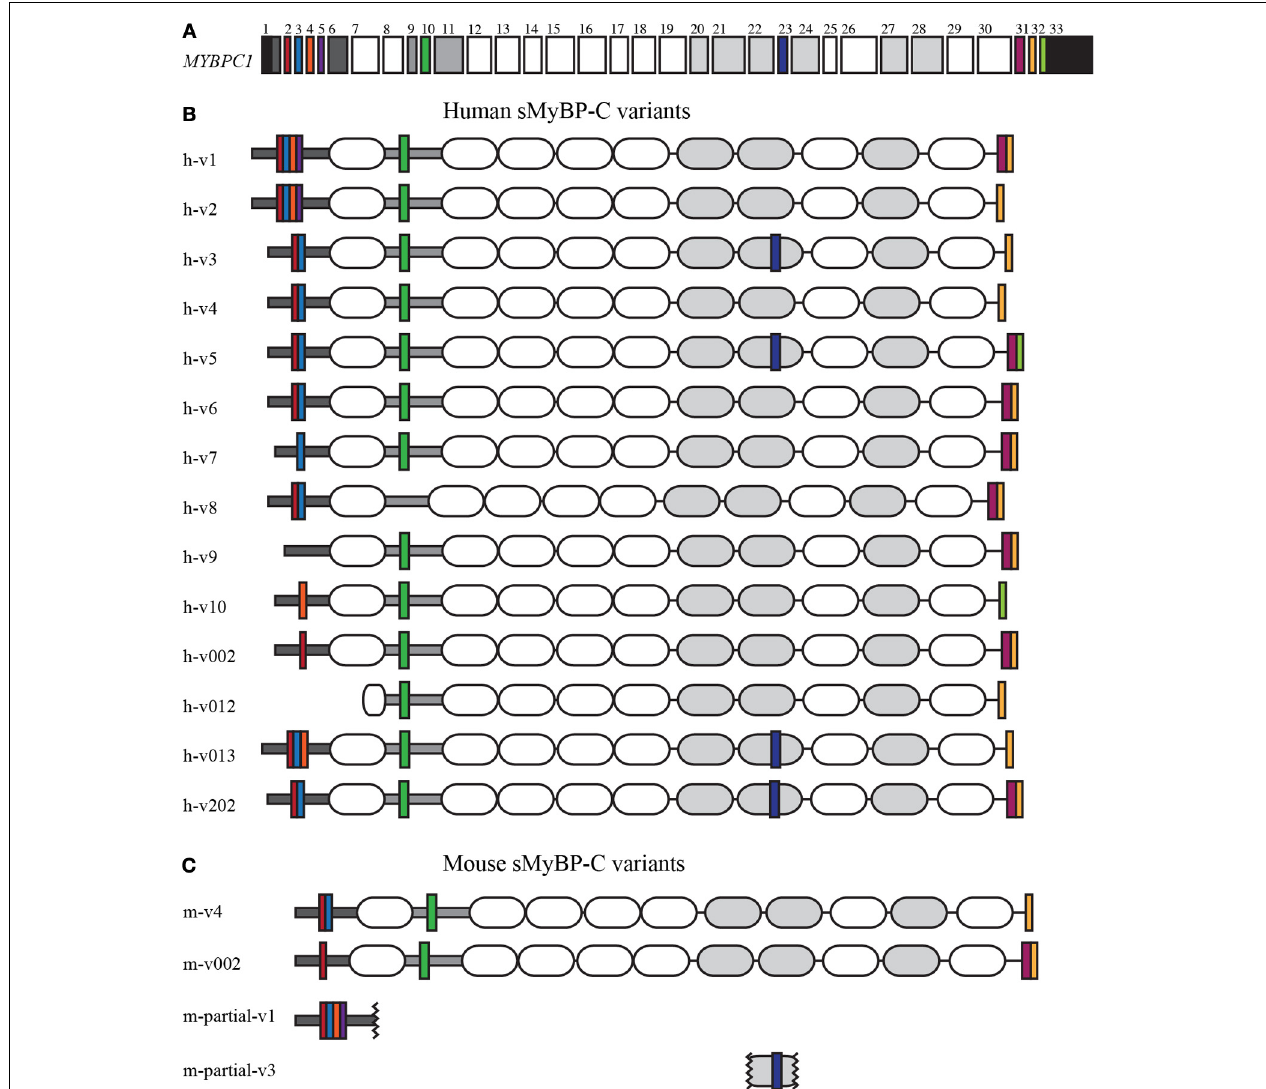
FIGURE 1 | Human and mouse sMyBP-C variants. Domain architecture of human and mouse sMyBP-C variants as listed in NCBI, Ensembl, and Vega illustrating their common domains and unique segments. (A) Exons 1-33 of the human MYBPC1 gene; the 5 (cid:2) and 3 (cid:2) UTRs are denoted in black. Dark gray boxes correspond to exons encoding the Pro/Ala rich region and the M-motif, while the white and light gray boxes represent exons that encode Ig and FNIII